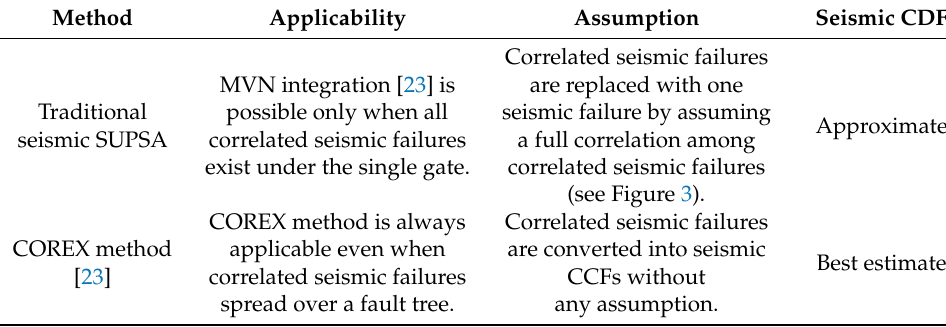
Figure 6. SCDF fault tree with seismic CCFs (Model B). Table 1. Seismic CDF calculation when correlated seismic failures spread over a fault